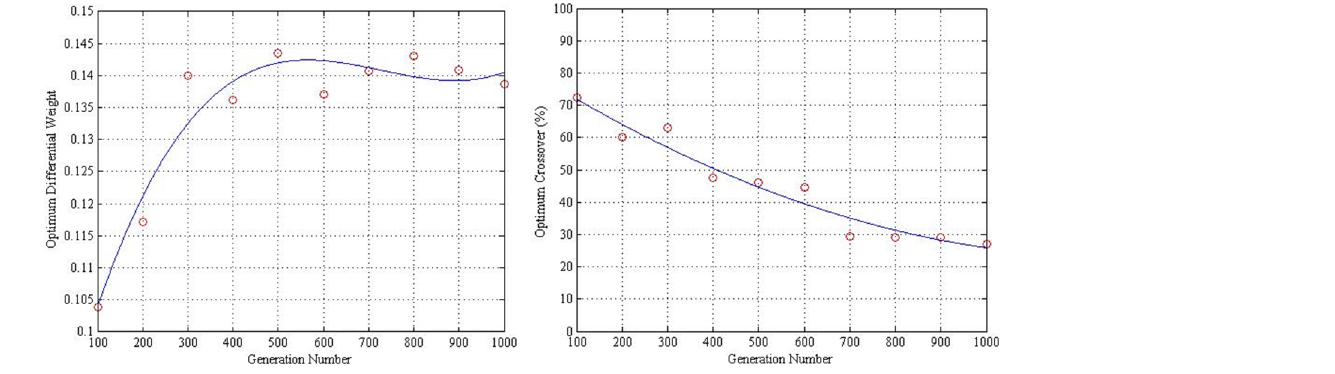
Fig 9. Optimum differential weight and crossover along generation number. doi:10.1371/journal.pone.0150558.g009 relation to the generation numbers may be determined by using Eqs (6) and (7), respectively,